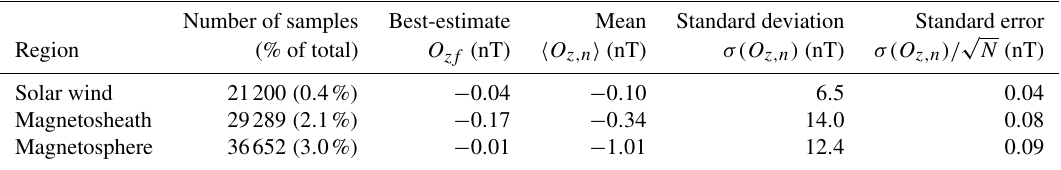
Table 2. Number of samples (time intervals) used in the statistical study for the offset determination and various offset estimates in units of nanotesla (best-estimate, mean, standard deviation, and standard error).